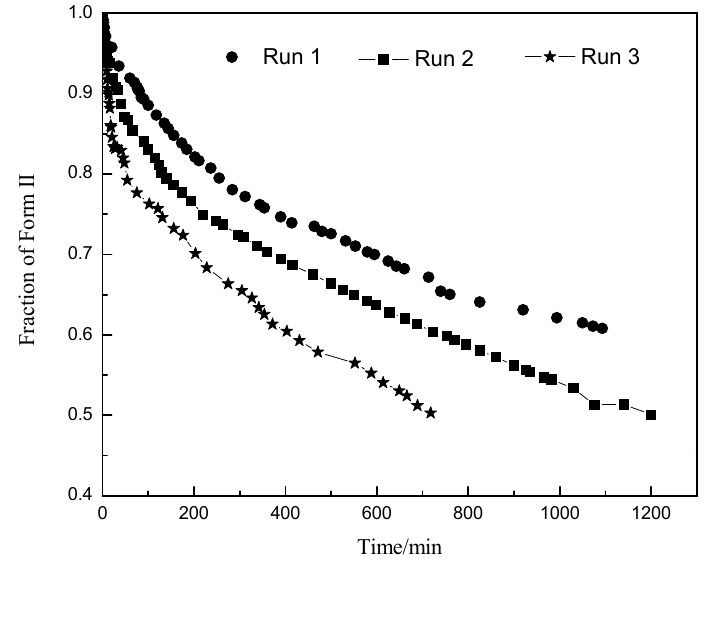
Figure 11. The conversion ratio of the two forms measured by Raman during Runs 1, 2 and